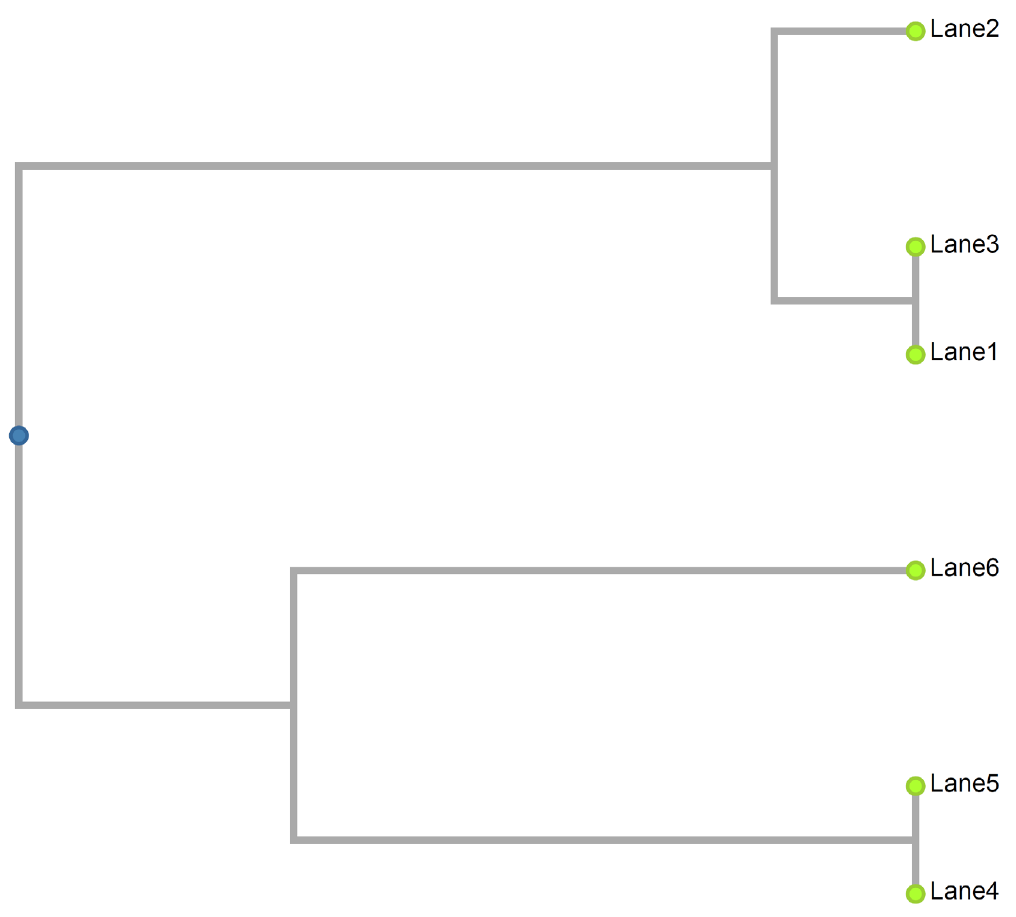
Figure 2. Dendrogram based on the pulsed-field gel electrophoresis (PFGE) results of all 6 methicillin-resistant Staphylococcus aureus (MRSA) isolates. Lanes 1–3 are Patient A’s (pelvic trauma patient) MRSA isolates from the first set of blood cultures (day 12), groin swab, and third set of blood cultures (day 13), respectively. Lanes 4–6 are Patient B’s (colonoscopy patient) MRSA isolates from nasal swab, blood culture, and rectal swab, respectively.